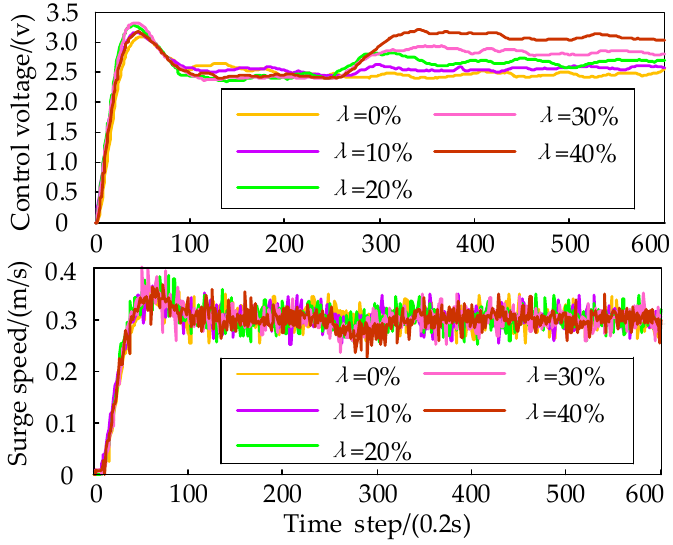
Figure 9. The waveform of the experimental data. As shown in Figure 9, AUV starts up at time step 1, and it begins sailing at a steady speed of 0.3 m/s after time step 100. This article researches thruster fault diagnosis at stable speeds, so the data from time step 101 to time step 600 are selected. According to the selected data, the surge speed signals with different percentages of thrust loss are more clearly expressed in Figure 10a. In addition, the change rate of the control voltage is calculated. The results are displayed in Figure